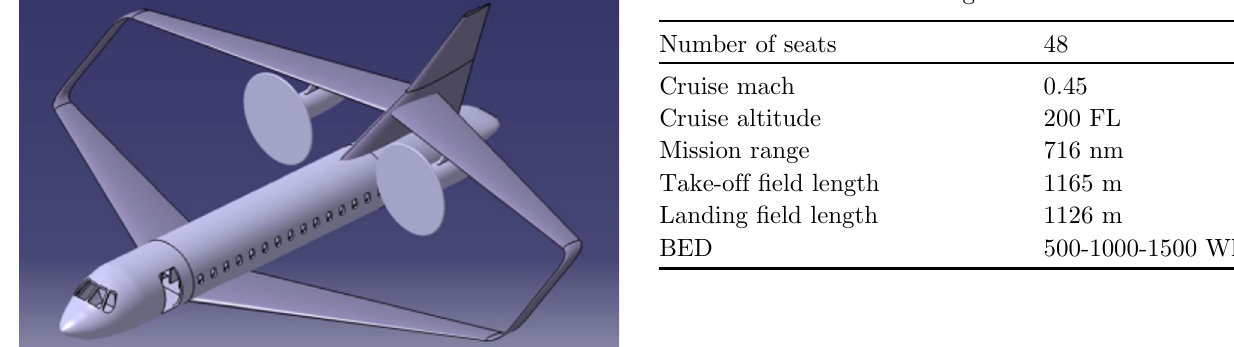
Table 4. TLARs for the regional Prandtl Plane aircraft.